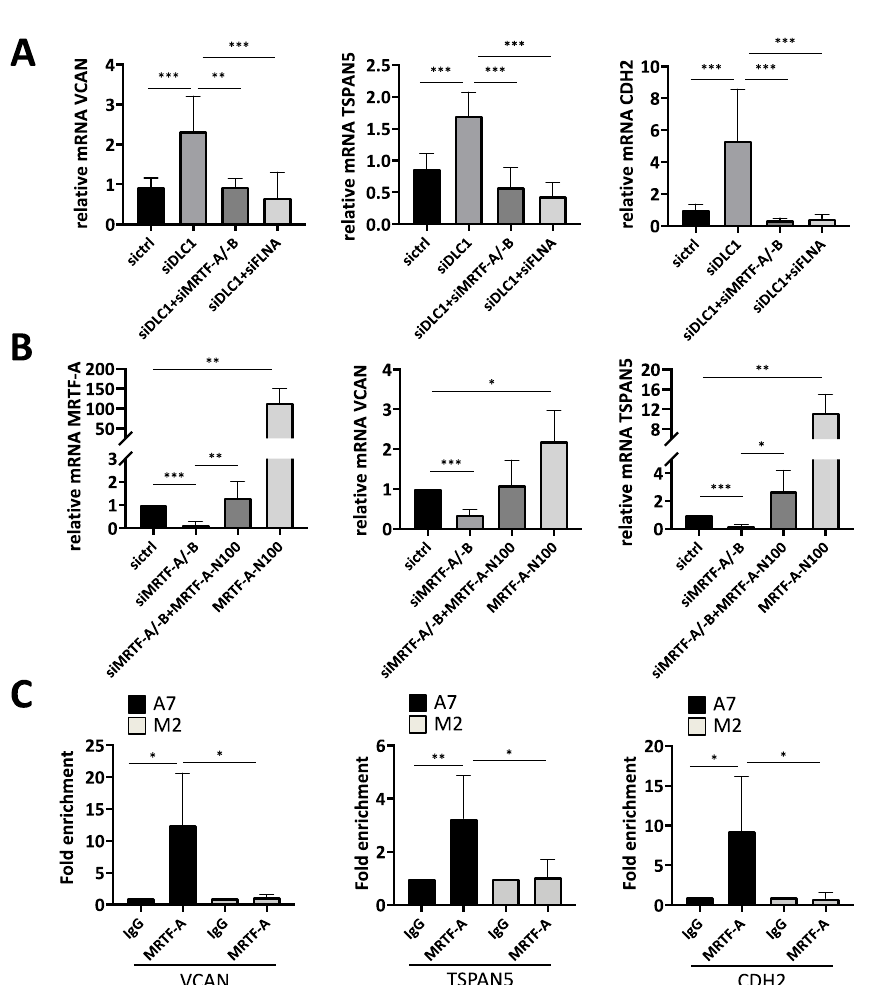
Figure 2. Transcriptional regulation of the newly identified DLC1-dependent genes. ( A ) mRNA expression of TSPAN5, VCAN and CDH2 in HepG2 cells transiently transfected with ctrl siRNA (sictrl), DLC1 siRNA (siDLC1) and a combination of DLC1 siRNA (siDLC1) and MRTF-A/-B siRNA (siMRTF-A/-B) or a combination of DLC1 siRNA (siDLC1) and FLNA siRNA (siFLNA) was assessed by qRT-PCR. The respective gene-specific primers were used and normalization to the 18 S rRNA was carried out. Values are means ± SD ( n = 3); **, p < 0.01 and ***, p < 0.001. ( B ) Expression of MRTF-A, VCAN and TSPAN5 mRNA in HuH7 cells after RNAi-mediated MRTF-A/-B knockdown (siMRTF-A/-B), followed by ectopic expression of MRTF-A-N100 for 3 days, determined by qRT- PCR as described above. Values are means ± SD ( n = 3); *, p < 0.05, **, p < 0.01 and ***, p <